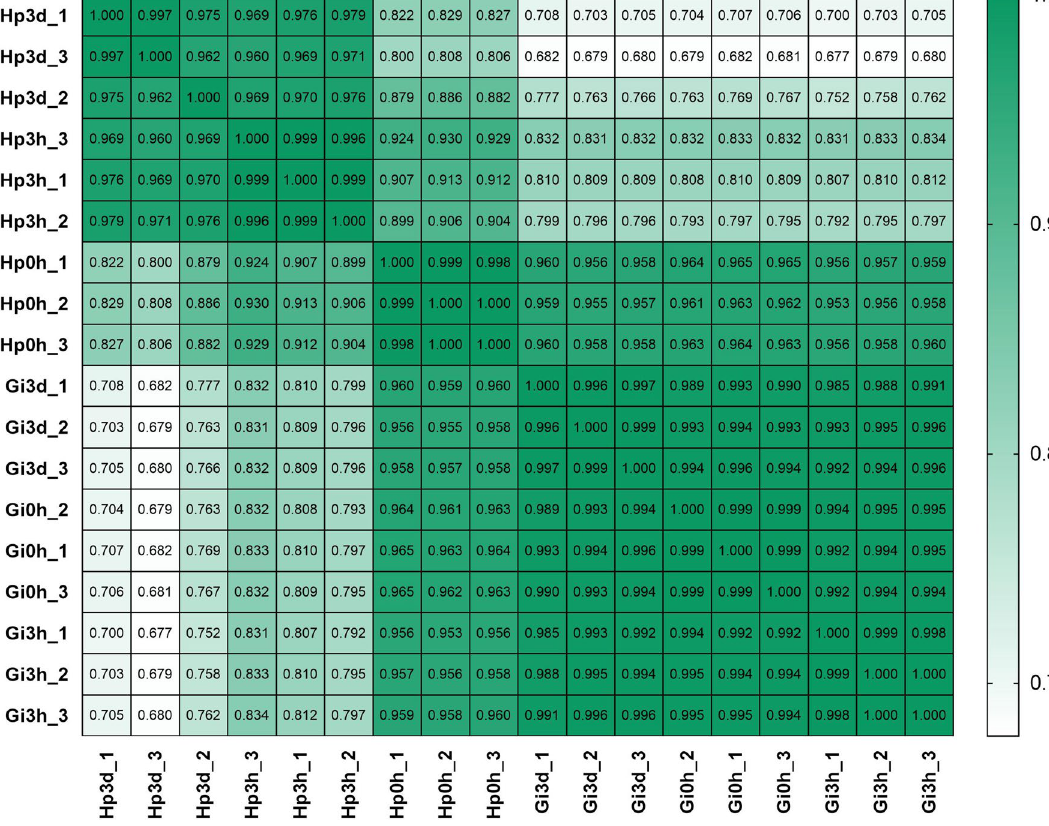
Figure 2. Pearson correlation analysis among the samples from different biological replicates. The abscissa and ordinate represent the sample name, and the correlation coefficient is represented by color; deeper color represents a stronger